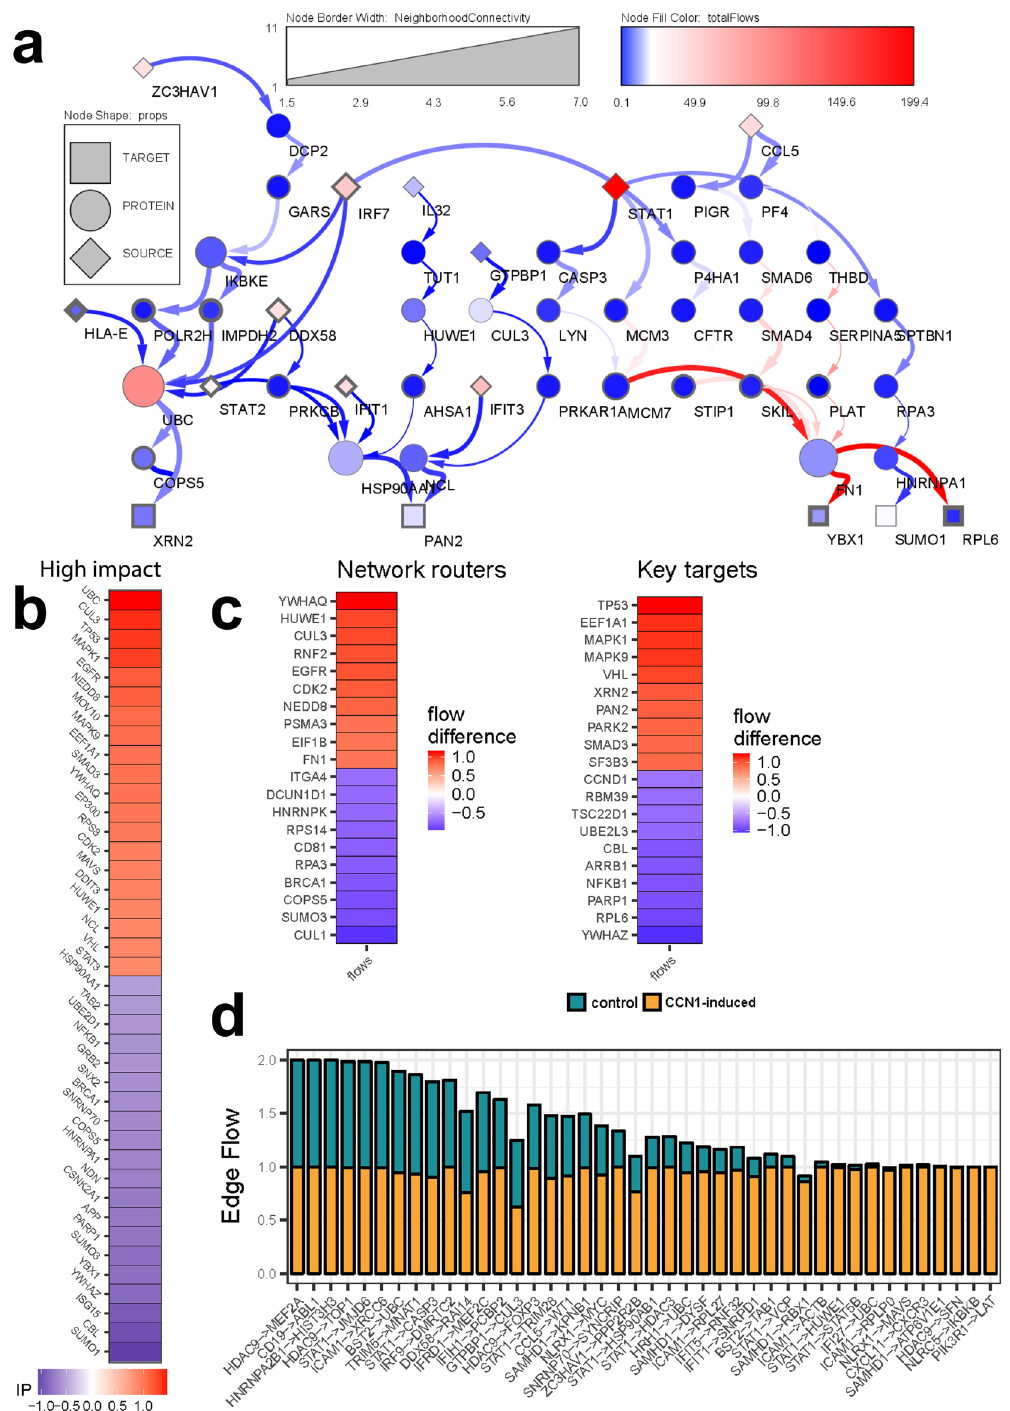
Figure 1. Prioritized flow subnetwork in glioblastoma. ( a ) Prioritized protein–protein interaction subnetwork. These interactions are represented by nodes (genes) and edges (interactions) with higher (red) and lower (blue) differential flows under CCN1-induced phenotype versus the uninduced control phenotype. Nodes consist of sources (diamonds), routers (circles), and sinks or targets (squares). Sources are previously published differentially expressed genes CCN1 induced biological states. ( b ) High impact genes experience significant shifts in regulation due to the number and directionality of interacting partners across phenotypes. ( c ) Flow differences. Heatmap showing node flow differences across uninduced control and CCN1-induced LN229 human GBM cells (n = 3 replicates) for top 20 network routers and key target genes showing high node flow difference (red) and low node flow difference (blue) in CCN1-induced GBM cells. ( d ) Key edges. Total edge flow profiles in uninduced control and CCN1-induced LN229 human GBM cells for edges with higher flows in CCN1-induced than in control